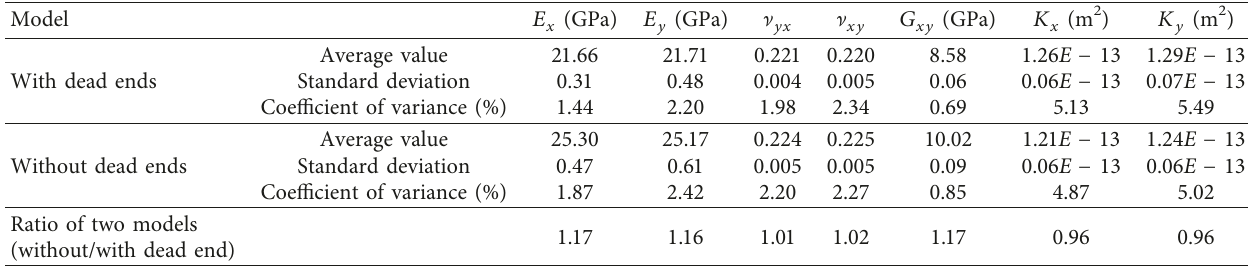
Table 2: Effective permeability and elastic properties of Sellafield fractured rock masses calculated with two models with and without dead- end fractures.